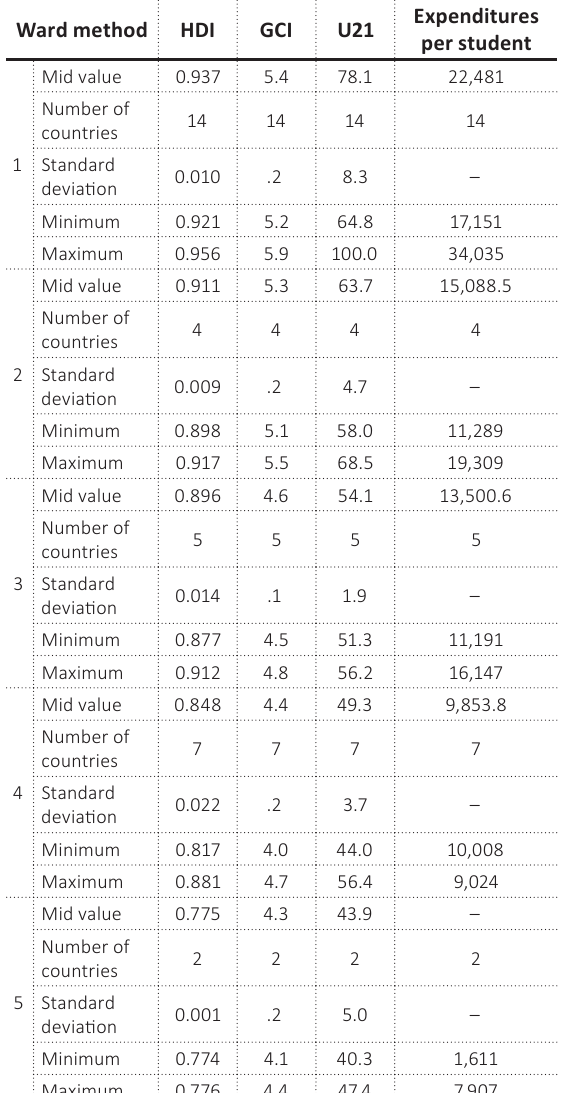
Table 3. The values of the indicators within clusters in 2018